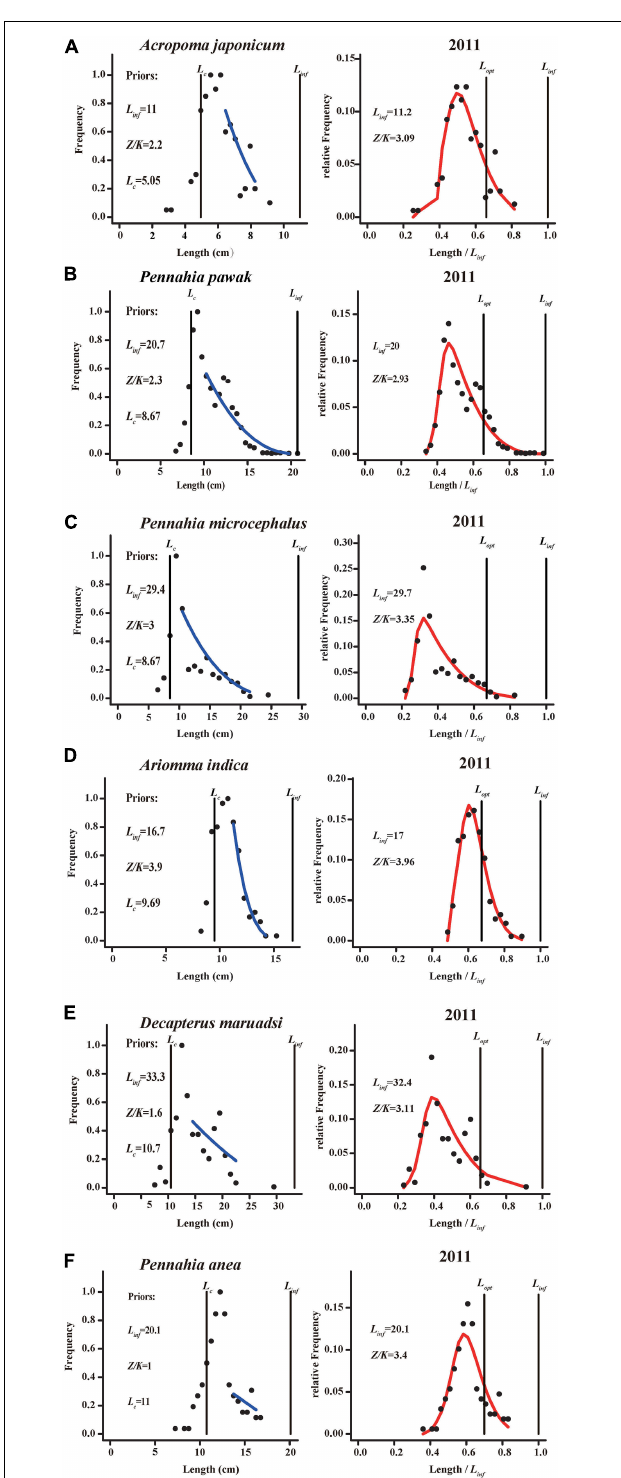
FIGURE 4 | The assessment results of two “slightly overfished” species and four “overfished” species with LBB method in Beibu Gulf. (A,B) Presents the result of Acropoma japonicum and Pennahia pawak , respectively. (C–F) Presents the result of Pennahia microcephalus , Ariomma indica , Decapterus maruadsi , and Pennahia anea , respectively.